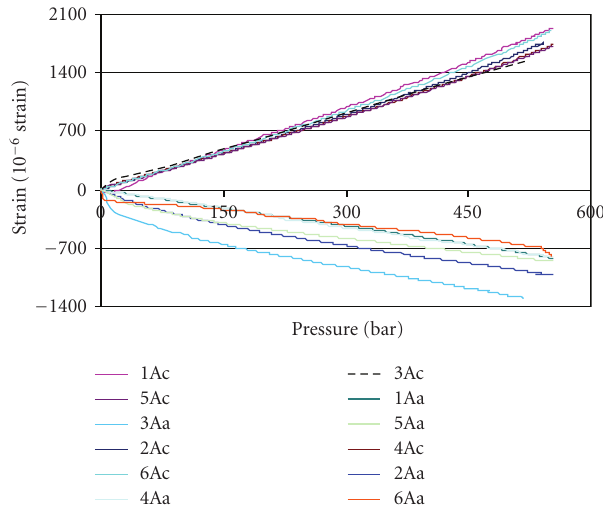
Figure 9: Diagrams of strain versus pressure for A tests.